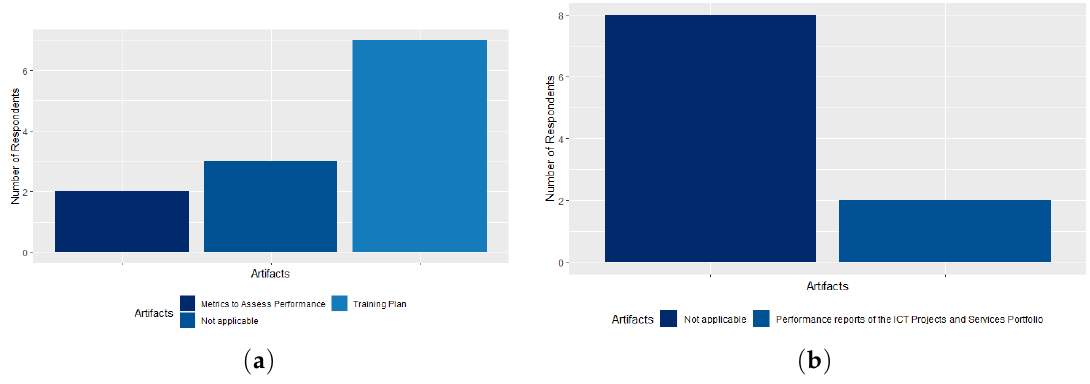
Figure 16. ( a ) The ICT People Management (Training, Performance, Roles, and Responsibilities) process artifacts; ( b ) Monitoring the Execution of the ICT Projects and Services Portfolio process artifacts.